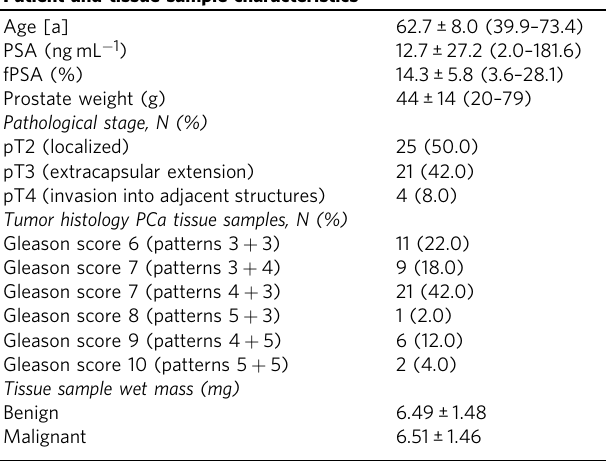
Table 1 Patient and tissue sample